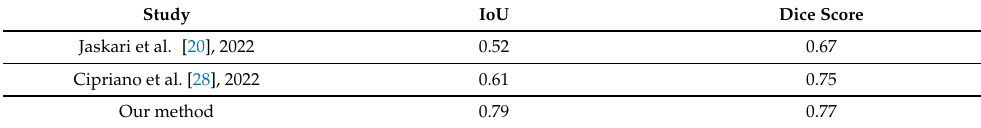
Table 6. Results of our technique on public dataset.